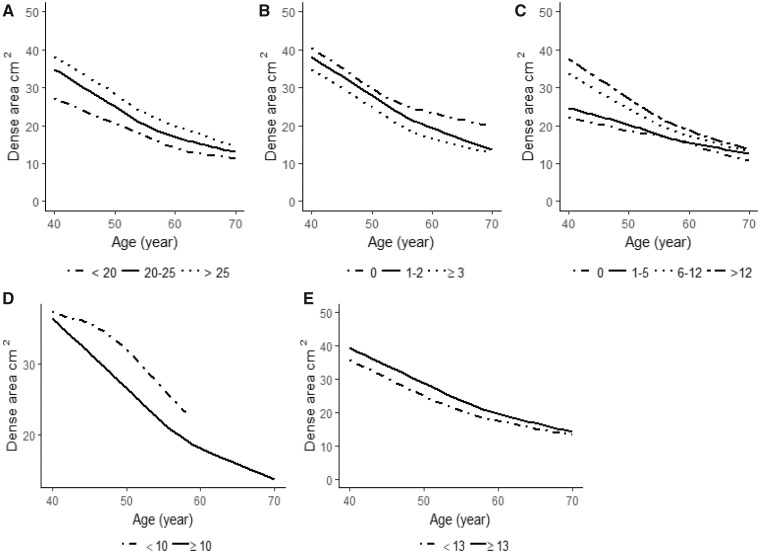
Mean baseline mammographic dense area (cm2) as a function of age at mammography screening and reproductive risk factors including: A) age at first birth (<20, 20–25, >25 years), B) number of children (0, 1–2, ≥3), C) breast-feeding duration among parous women (0, 1–5, 6–12, >12 months), D) time since last birth (<10, ≥10 years) at study entry, and E) age at menarche (<13, ≥13 years).